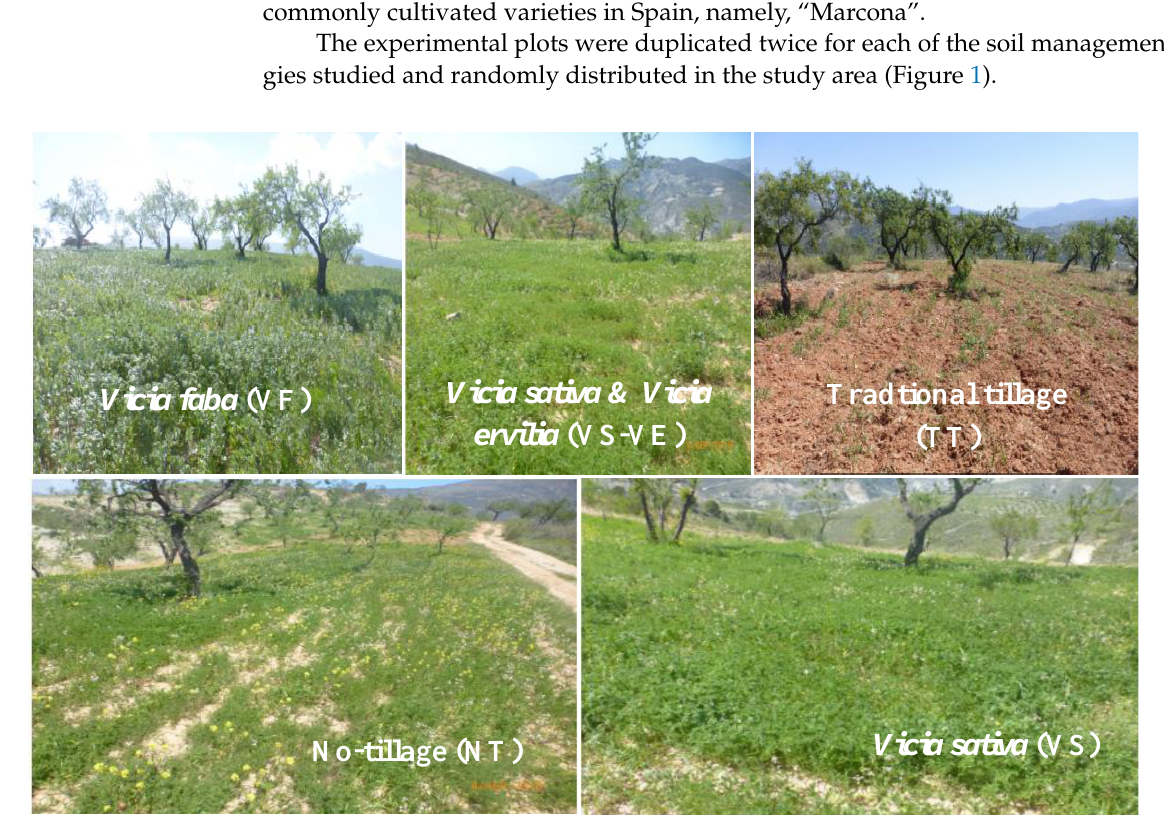
Table 2. Soil management strategies applied in almond organic production system during study period (2016–2021).